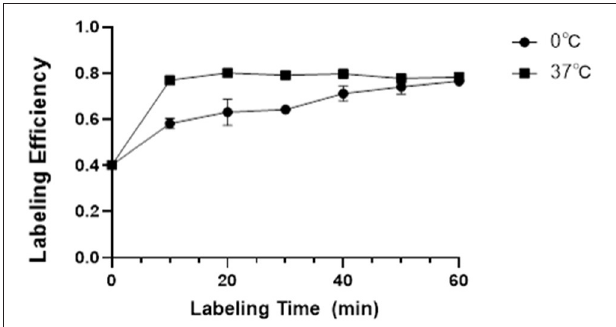
FIGURE 1 | The LE and its influencing factors. Relationship between labeling temperature, incubation time, and the LE of 18 F-VS-RBCs ( n = 4).